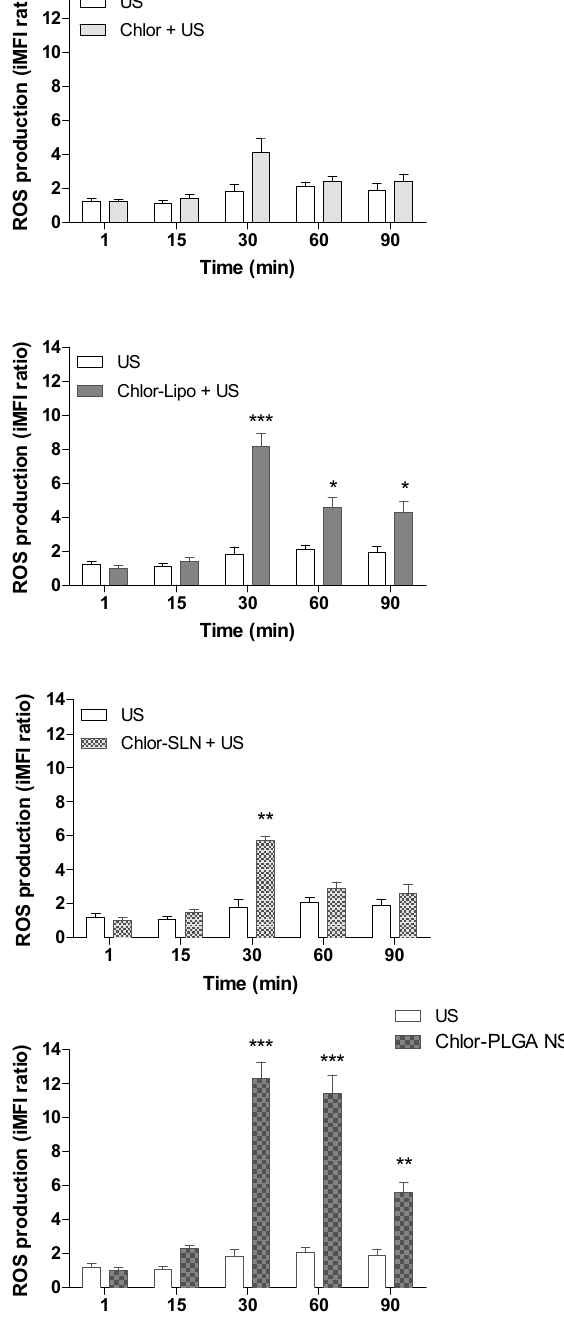
Figure 7. PC-3 ROS production after sonodynamic treatment as a function of time. PC-3 cells were exposed to US (1.5 MHz for 5 min at 1.5 W / cm 2 ) or pre-incubated with the various Chlor formulations at the same concentration (5 µ M) and the proper time (6 h for Chlor-Lipo or Chlor-SLN and 24 h for Chlor or Chlor-PLGA NSs) and then exposed to US (1.5 MHz for 5 min at 1.5 W / cm 2 ). ROS levels were determined according to the DCFH-DA assay by flow cytometry and expressed as the integrated mean fluorescence ratio (iMFI), as described in Materials and Methods. * p < 0.05, ** p < 0.01, *** p <